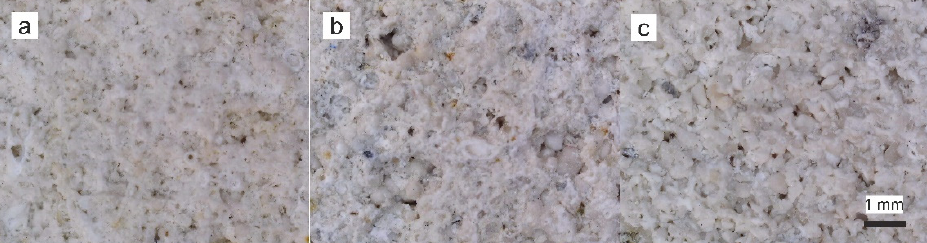
Figure 3. Micro-fabric of tested porous limestone, ( a )—fine-grained limestone from Sóskút (SF); ( b )—medium-grained limestone from Sóskút (SM); ( c )—medium-grained limestone from Fert ő rákos (FR).